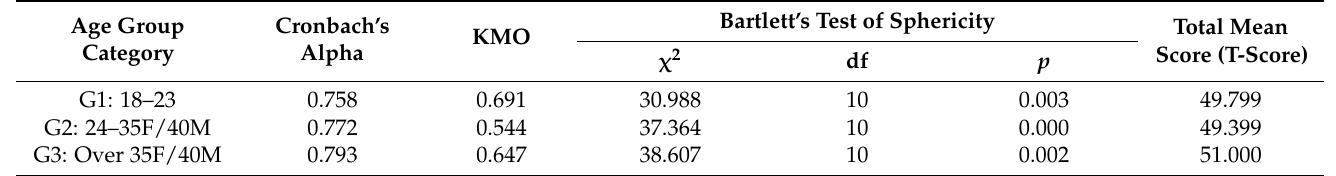
Table 4. Statistical analysis of the data for the Zuckerman–Kuhlman Personality Questionnaire (ZKPQ).